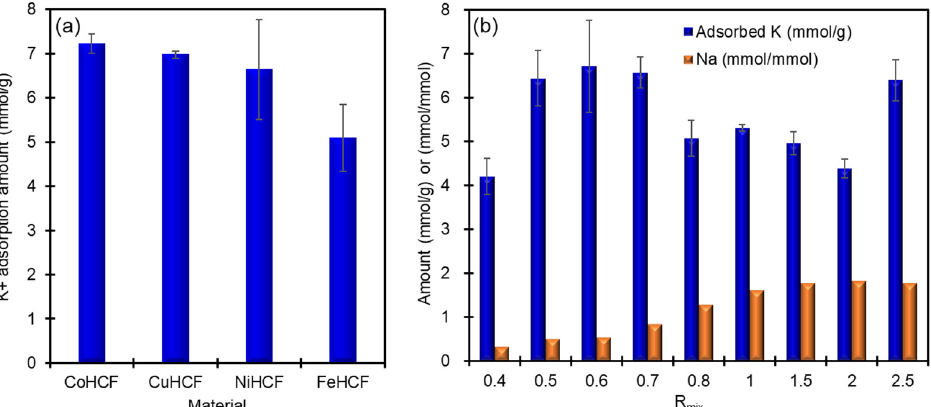
Figure 1. Potassium adsorption from KCl-added artificial seawater using different powder-form MHCF adsorbents. ( a ) MHCF with different transition metals (M = Co, Cu, Ni, Fe), and ( b ) K adsorption onto CoHCF prepared with different composition, R mix from 0.4 to 2.5. 10 mg adsorbent, 10 mL solution, 600 rpm mixing for 24 h at 25 °C. Na (mmol/mmol) is the amount in the material. Because the change was negligible compared to the initial concentration, the amount of Na released was not analyzed.